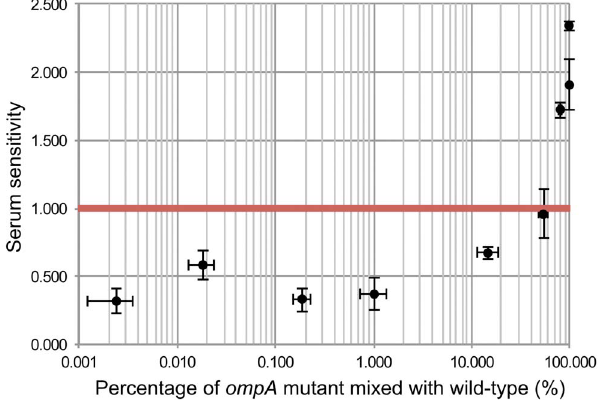
Figure 7. Intrans complementation of wild-type EC958 protects ompA mutants from serum killing. Wild-type EC958 and an EC958 ompA mutant were mixed at different ratios, exposed to human serum for 90 minutes, and the EC958 ompA mutant was examined for its sensitivity to human serum (expressed as the 2 log 10 CFU difference between time 90 and time 0). The red line indicates the threshold below which a strain was considered resistant to serum killing. The EC958 ompA mutant was protected from killing when present at a percentage of 15% or less in the mixed bacterial suspension.